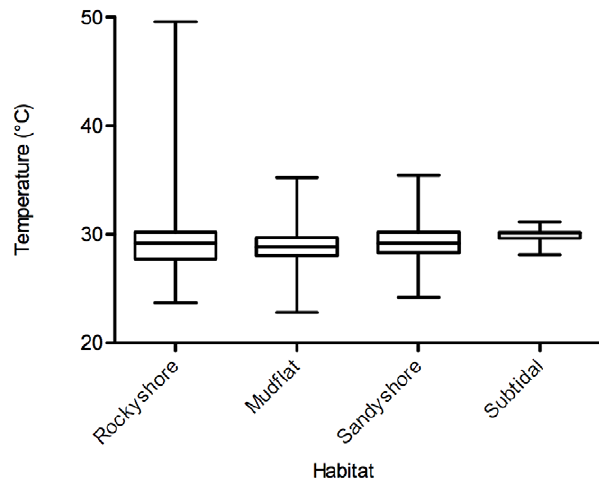
Figure 1. Temperature profiles of major habitats in Singapore. The box-whisker plots show maximum, minimum, mean and 95 percentile temperatures from temperature logger data deployed at each habitat for at least three months.